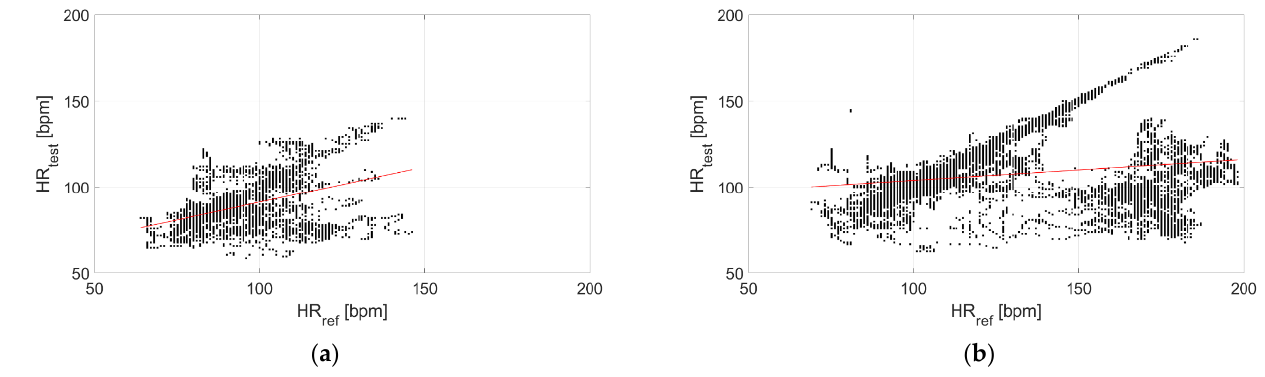
Figure 14. Distribution of deviations related to ( a ) Resting and ( b ) During activities, including re- cordings both at in-water and dry conditions performed with Polar Vantage V2 (reference instru- ment: Polar H10).